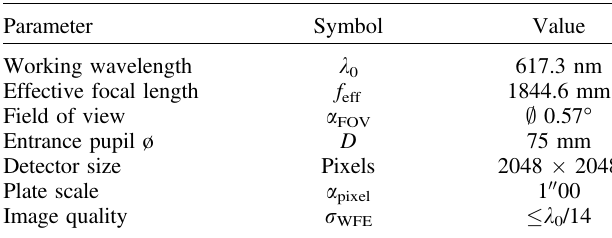
Table 1. Optical